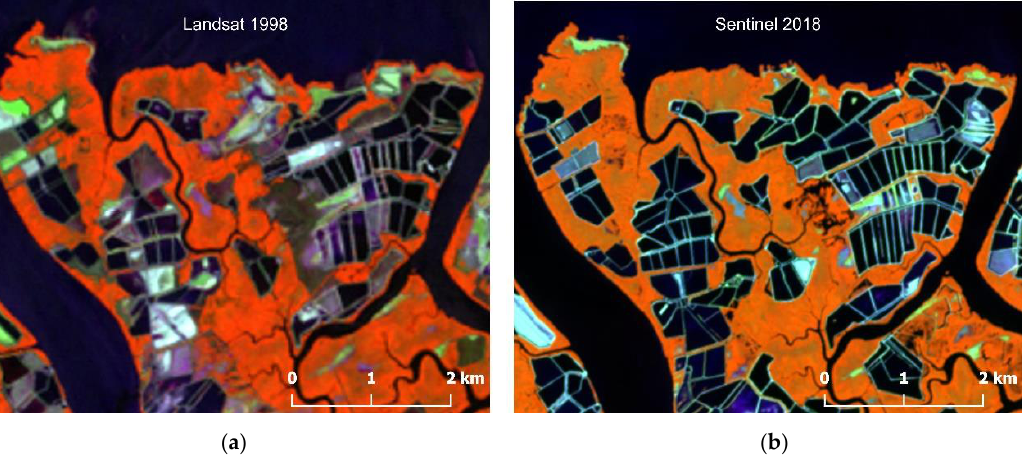
Figure 3. ( a ) Landsat RGB image combines the near infrared (NIR), shortwave infrared (SWIR), and red bands, ( b ) sentinel 2A RGB image combines the vegetation red edge, shortwave infrared (SWIR), and red bands. These composites display mangrove forests in a reddish-brown color.